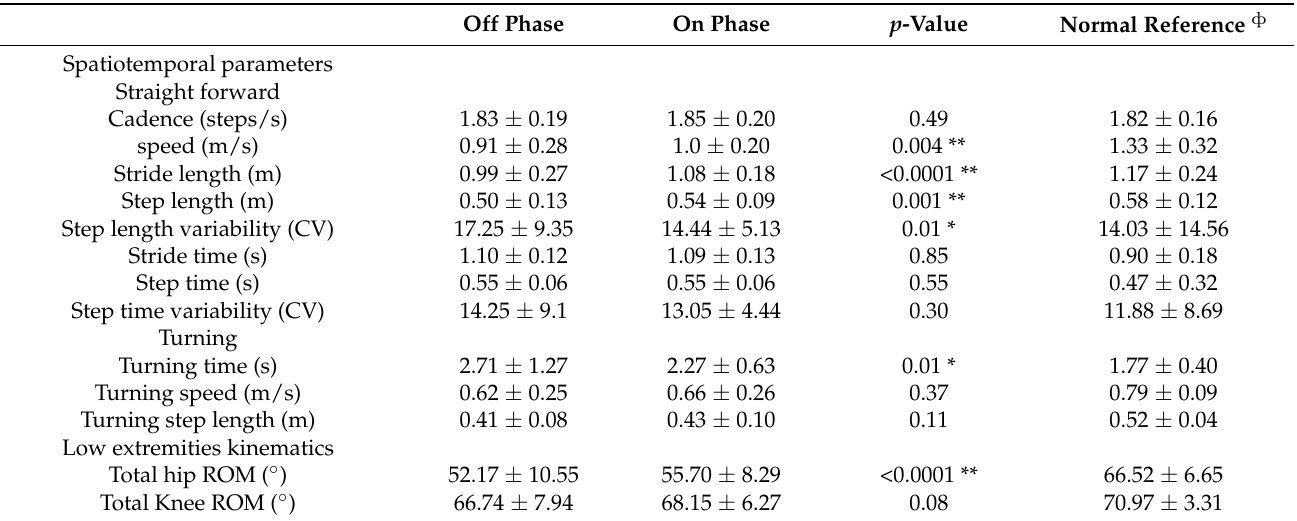
Table 3. Effect of dopamine replacement therapy on spatiotemporal and kinematic variables during the walking gait cycle.